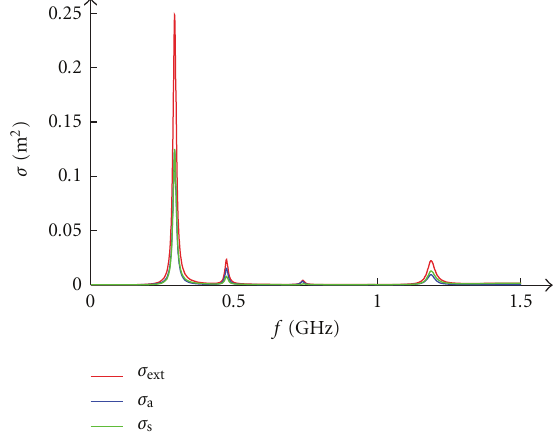
Figure 4: Geometry of the two arm spherical helix with circum- scribing sphere radius a = 62 mm and wire radius R w = 2 mm.